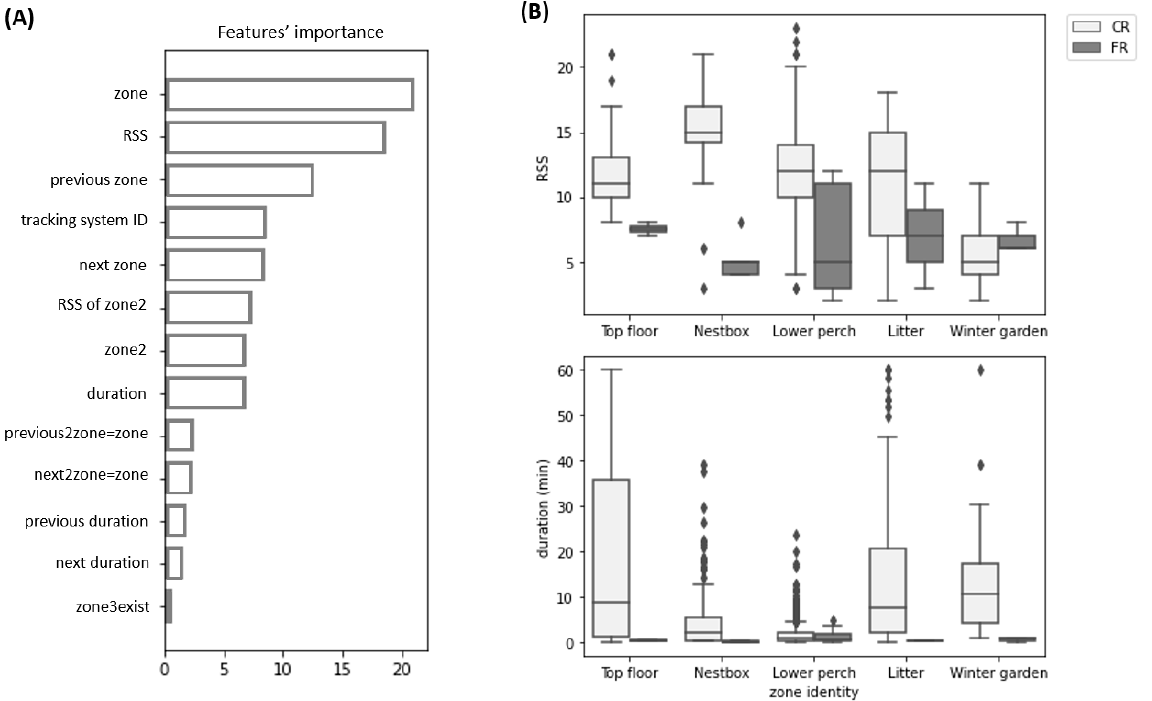
Figure 3. ( A ) Normalized importance of features for the selected CatBoost model. ( B ) Box plots of the RSS (top) and duration of stay (bottom) of the test dataset registrations, split into CR (light grey) and FR (grey), as produced by video observations, are displayed for each zone.